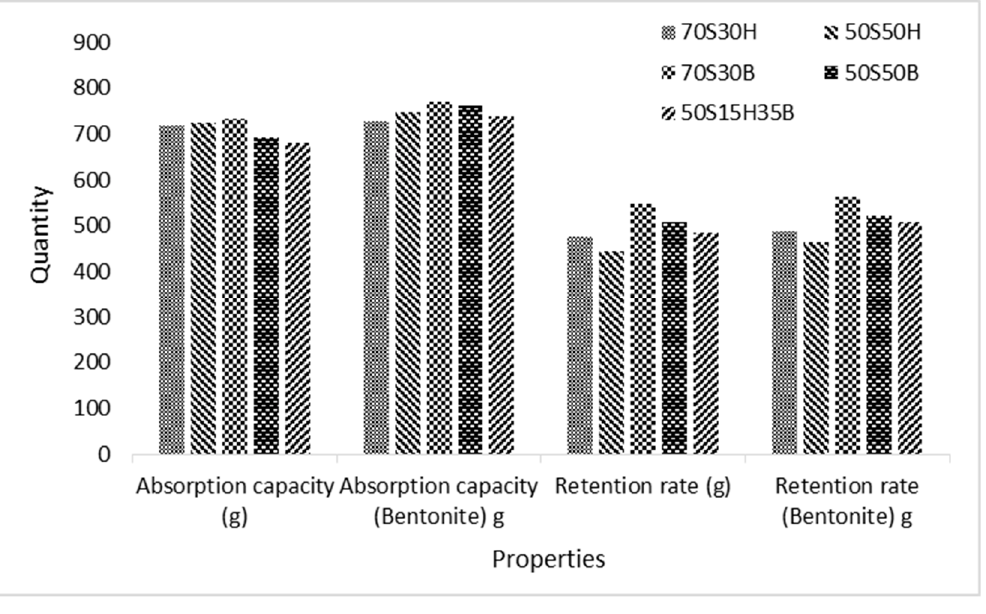
Figure 5. Absorption capacity and retention rate in baby diapers produced with different fluff pulps.